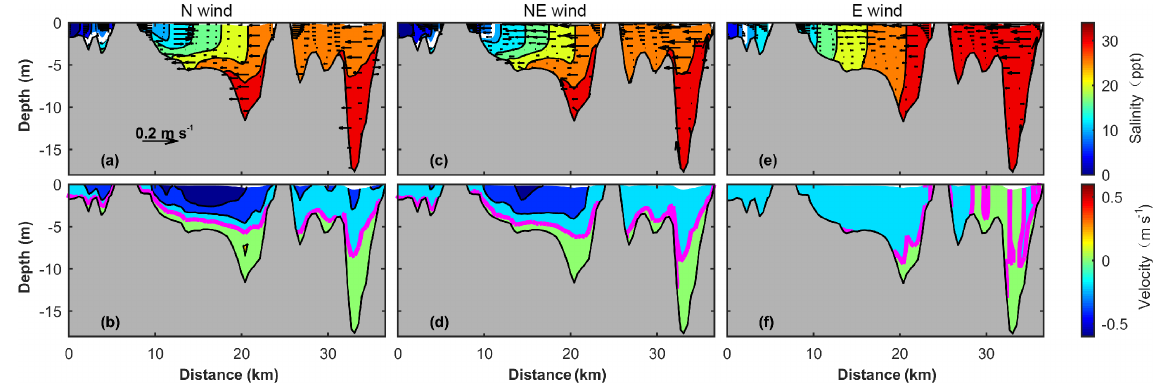
Figure 15. Comparison of 50h of averaged salinity and current at the cross-section in the middle of the estuary (T4). The top panels (a, c, e) show salinity and lateral current, while the bottom panels (b, d, f) show axial current (in ms − 1 ). The white lines in the upper panels show the 10ppt isohaline. The magenta lines in the lower panels show the 0ms − 1 current